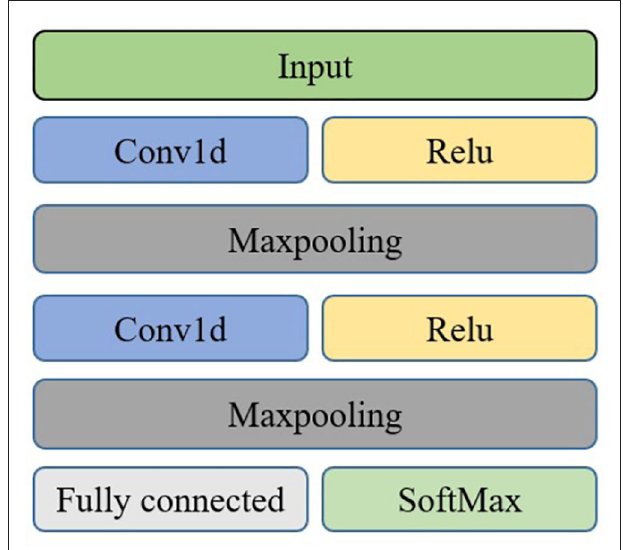
FIGURE 6 | Network structure diagram of brain